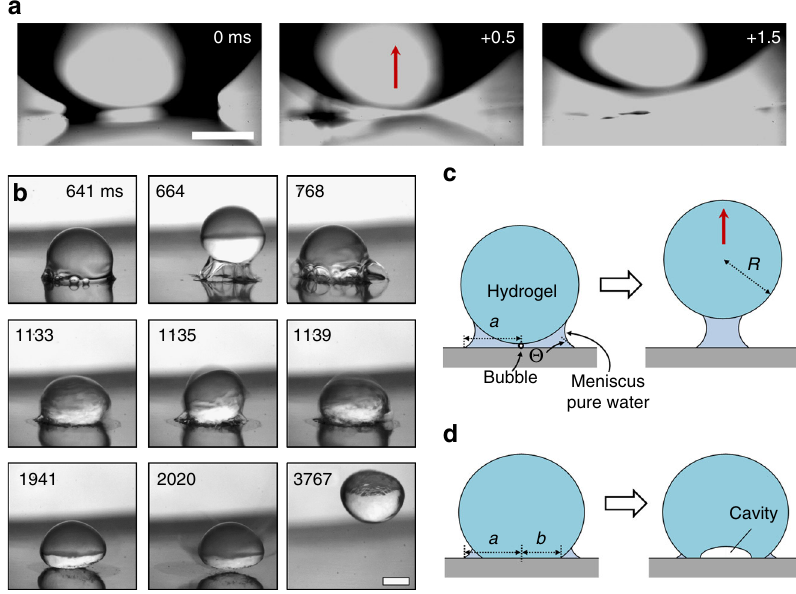
Fig. 2 Hydrogel drop jumping due to vaporization of the meniscus. a Time snapshots of the jumping of a 25 kPa hydrogel drop (Supplementary Movie 3). The meniscus is clearly visible in the fi rst image and is completely gone 0.5 ms later after meniscus explosion. The 1.5 ms image illustrates the upward motion of the hydrogel. Scale bar: 0.5 mm. b Evolution of a 2 kPa hydrogel drop jumping after burning. Bubbles fi rst form underneath the drop (Supplementary Movie 4). The hydrogel drop attempts to jump (664 ms), but adhesion by fi brils holds it back. The drop remains on the surface and rapid vibrations are observed (1133 – 1139 ms). The polymer fi brils start to burn away and the drop is released from the surface (2020 ms). Scale bar: 1 mm. Illustrations for the proposed mechanism of ( c ) jumping of the 25 kPa hydrogel in part ( a ) and ( d ) cavity formation and burning of the 2 kPa hydrogel in part ( b